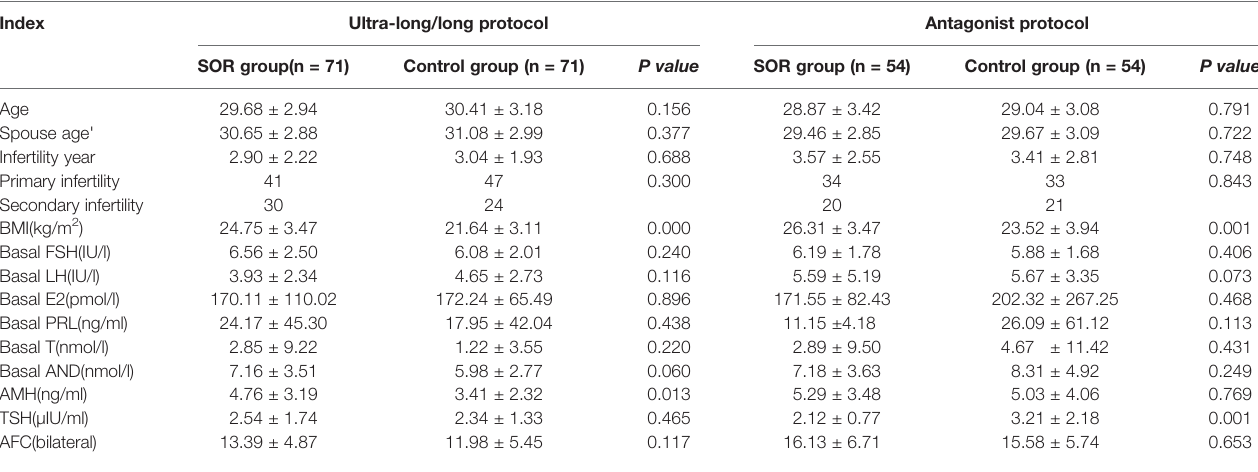
TABLE 1 | Baseline information of all patients in